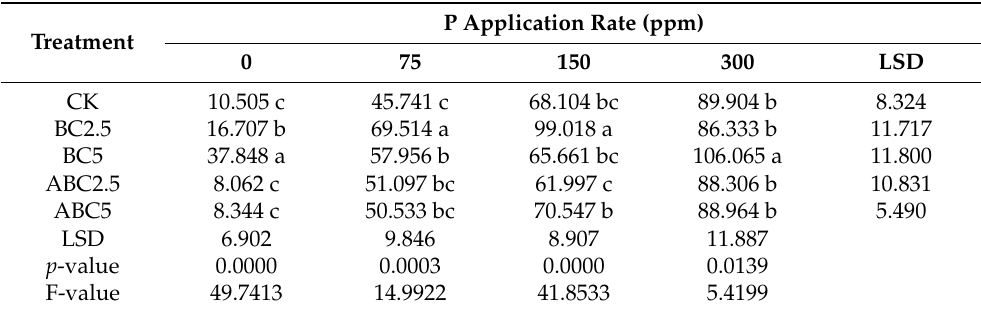
Table 3. Impact of BC and ABC applied at different rates with different P fertilizer application rates on AB-DTPA extractable P of soil (mg kg − 1